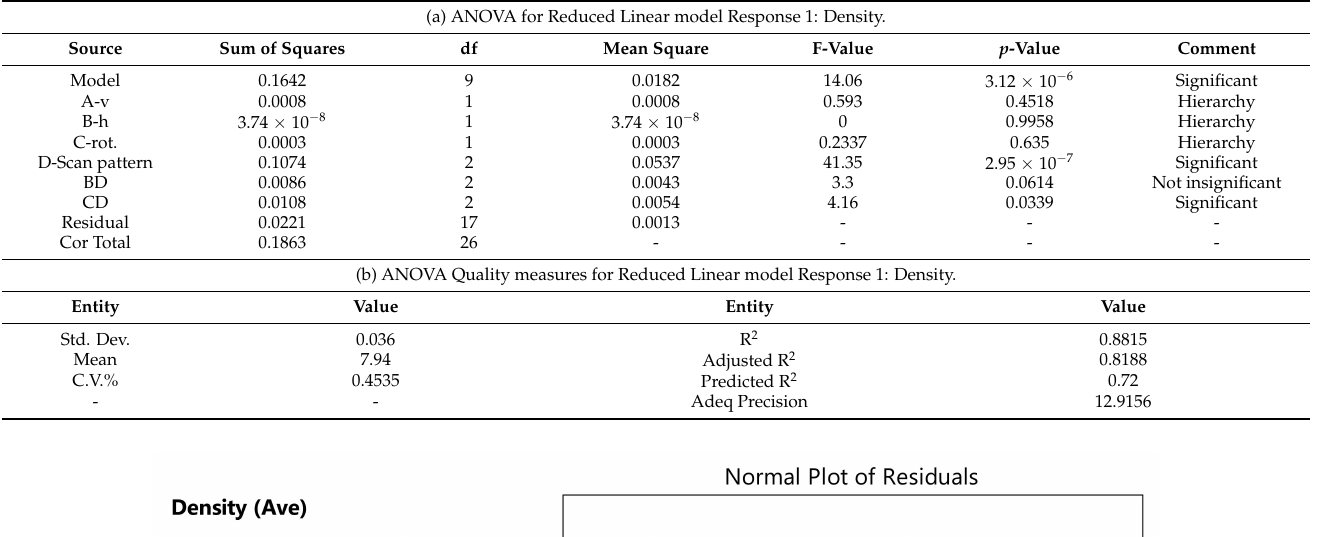
Table A3. ANOVA results: Density. (a) ANOVA for Reduced Linear model Response 1: Density.